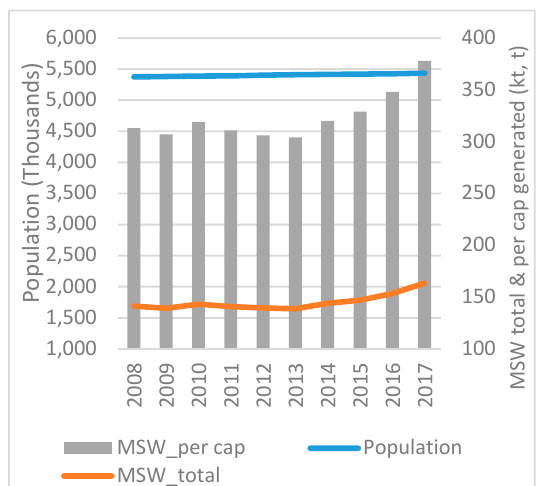
Figure 49. Population and MSW production in Slovakia 2008–2017 (EUROSTAT 2019a, 2019c).